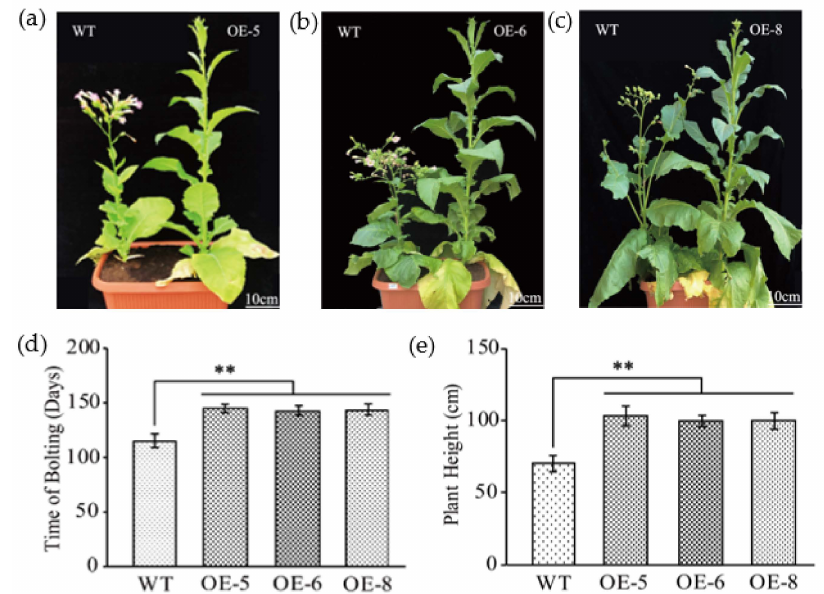
Figure 2. Flowering time and plant height analysis in GhKTI12 transgenic plants. ( a – c ) Plant height (Scale = 10 cm) and initial bolting morphology of WT and GhKTI12 transgenic tobacco. Statistical comparison of morphological analysis in ( d ) Initial bolting time. ( e ) Plant height (Scale = 10 cm). Bars in the graph show the standard mean error. Asterisks indicates significant differences between wild type (WT) and GhKTI12 transgenic plants analyzed by Student’s t -test, p < 0.01 (**). Data were collected from 10 representative